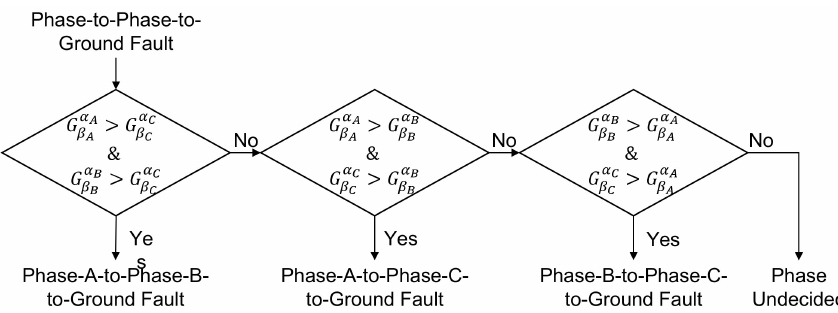
Figure A5. Phase-to-Phase-to-Ground fault identification